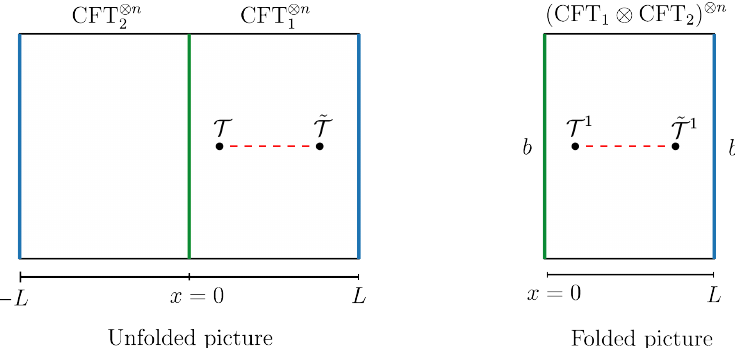
Figure 1: Representation of a system made by two CFTs joined through an interface in the unfolded (left) and folded (right) picture. The interface and the open boundaries are shown by green and blue lines, and are associated to boundary conditions of type b and b ′ ,